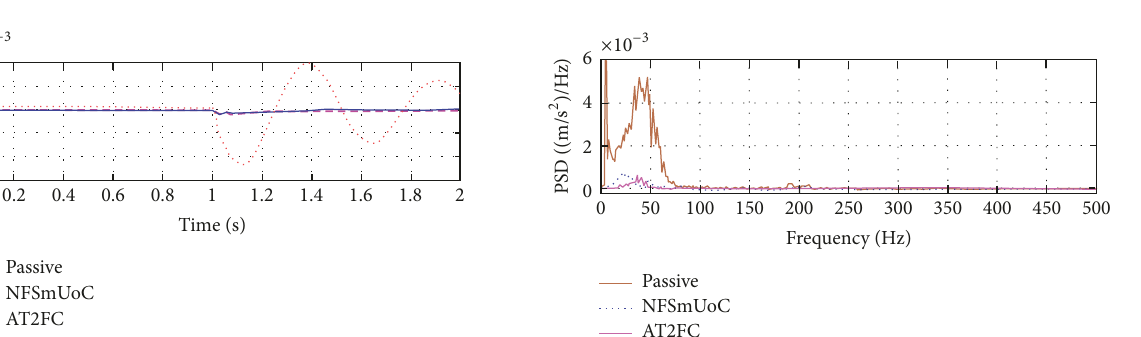
Figure 17: PSD of the acceleration signal of the three suspension systems.